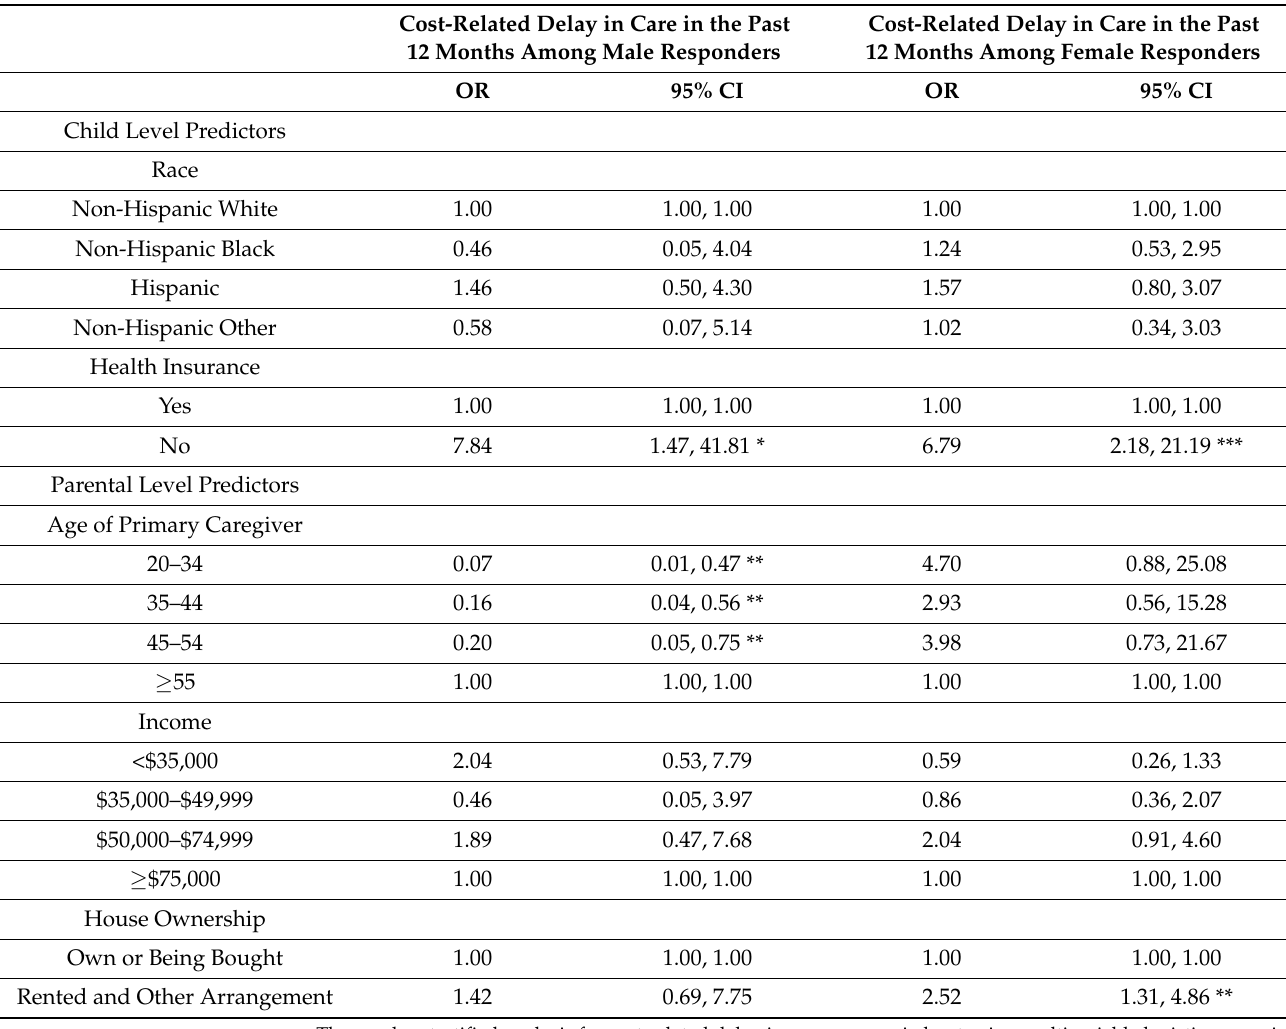
Table 3. Sex-stratified multivariable model of cost-related delay in medical care. Cost-Related Delay in Care in the Past Cost-Related Delay in Care in the Past 12 Months Among Male Responders 12 Months Among Female Responders OR 95% CI OR 95%